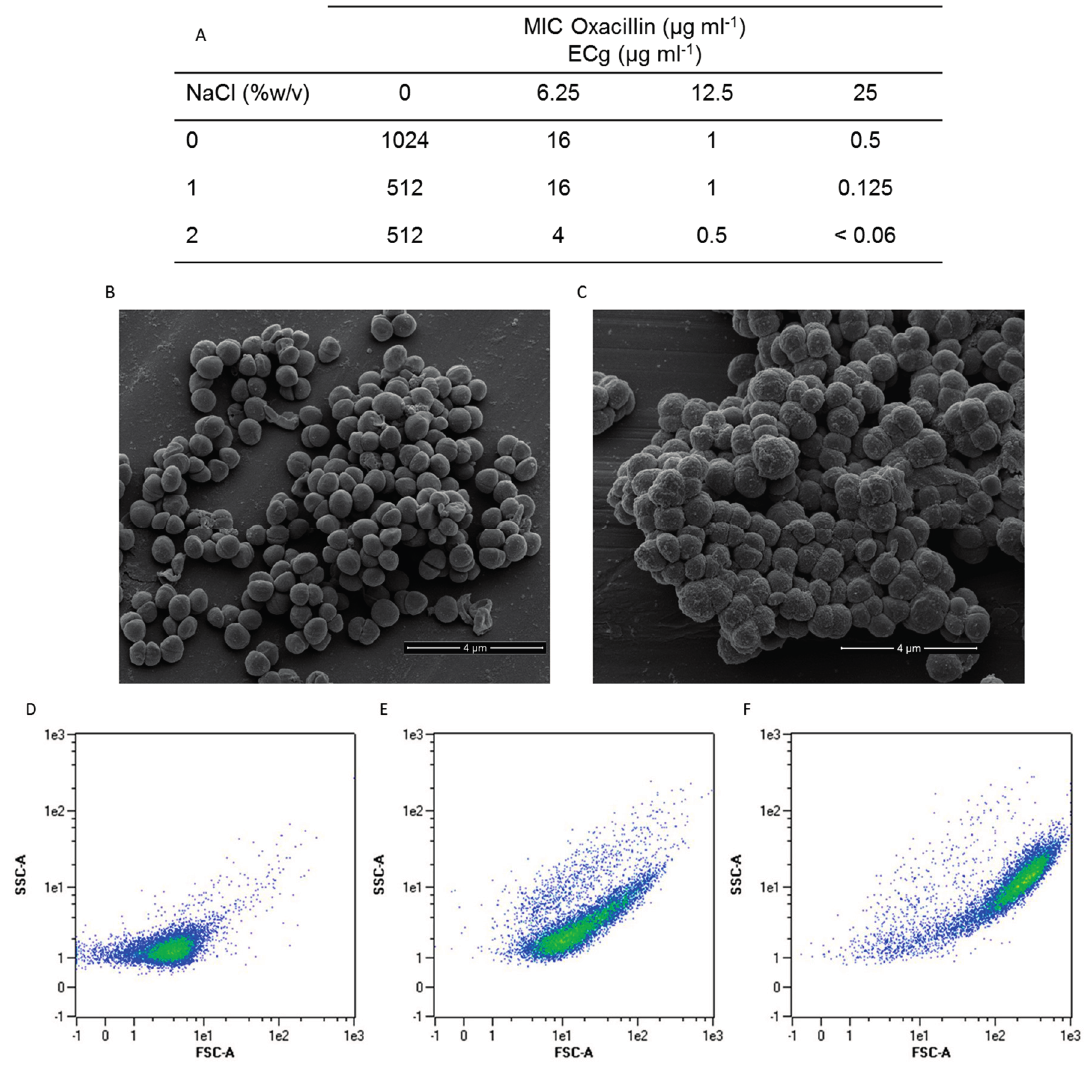
Figure 1. ECg induces reversible changes to the EMRSA-16 phenotype. ECg abrogates β -lactam (oxacillin) resistance in Mueller-Hinton (MH) broth and NaCl-supplemented MH broth ( A ) Scanning electron microscopy reveals that incorporation of 12.5 µg/mL ECg into growth medium alters the appearance of the staphylococcal cells ( C ) in comparison to control cells grown in the absence of the compound ( B ). Flow cytometric analysis (10,000 events) of EMRSA-16 grown in the absence ( D ) or presence of 12.5 µg/mL ECg for 1 h ( E ) or 4 h ( F ) shows increases in size (FSC; forward scatter) and changes to cell granularity (SSC; side scatter) as a consequence of exposure to the